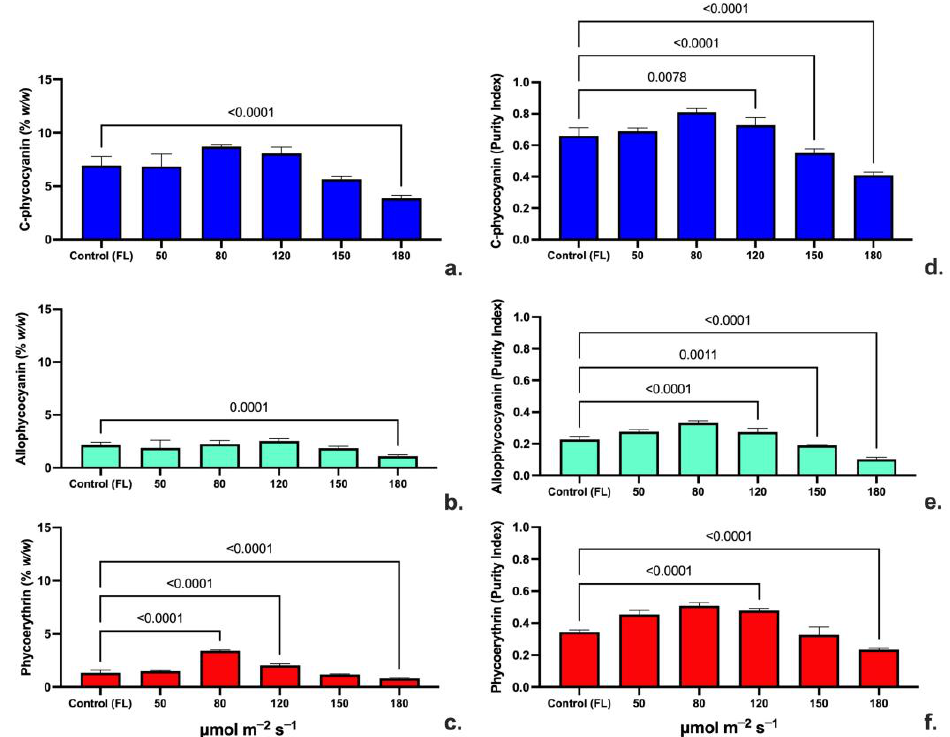
Figure 5. The concentration of phycocyanin (C-PC) ( a ), allophycocyanin (APC) ( b ), and phycoerythrin (PE) ( c ) and their purity ( d – f ) under different intensities of white/red:blue LEDs. The previous results highlighted the intensity of 80 µ mol m − 2 s − 1 for evaluating the light:dark cycle. According to the results from the ANOVA analysis shown in Figure 6, when Oscillatoria sp. OSCI_UFPS001 is exposed to more extended light regimes at 80 µ mol m − 2 s − 1 , the biomass increased significantly (<0.0001) by up to 1.6 g/L (24:0 photoperiod) in comparison with the control, which used fluorescent lamps at 100 µ mol m − 2 s − 1 (0.49 g/L, 12:12 photoperiod).